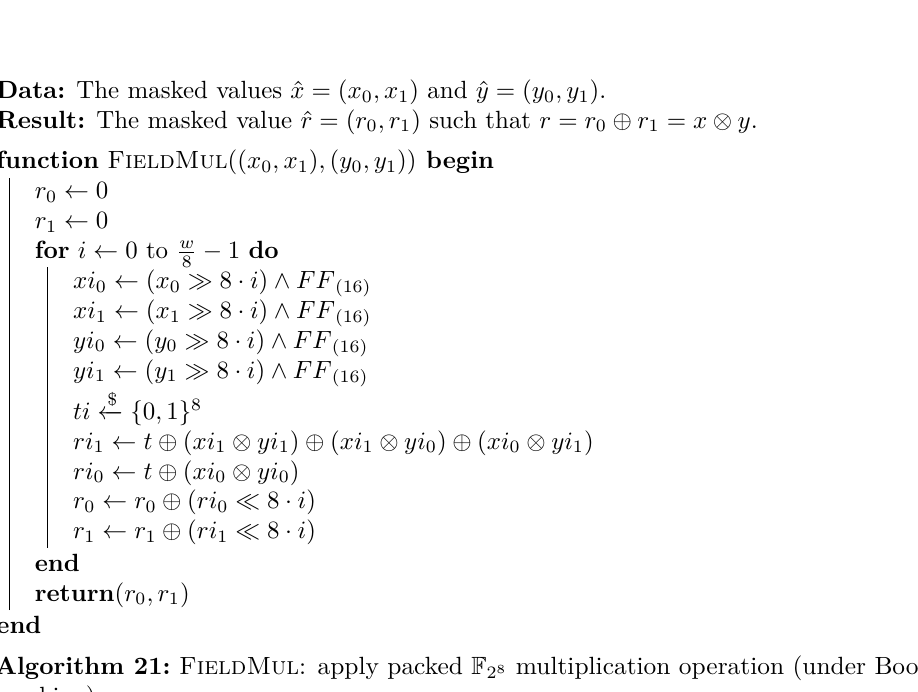
affine transform operation (under Boolean 2 8